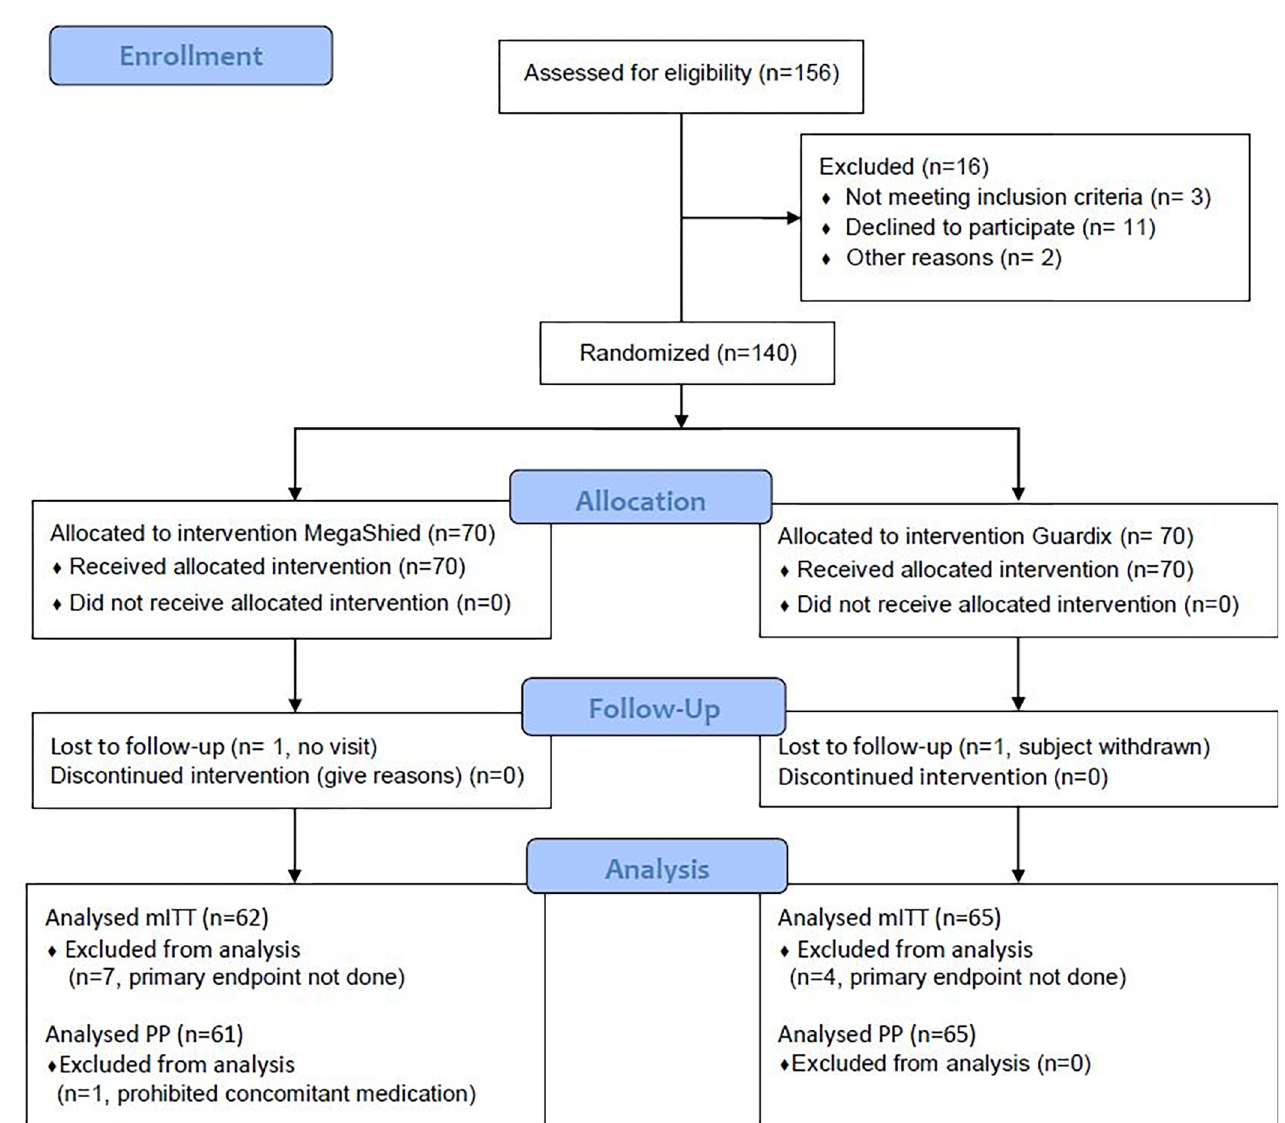
Fig 1. Disposition of patients. https://doi.org/10.1371/journal.pone.0273215.g001 Kangbuk Samsung hospital, and 26 from Seoul St. Mary’s Hospital (S1 Table). No deviation occurred in the randomization process. One patient in the MegaShield 1 group was excluded due to loss of follow-up. One patient in the Guardix-SG 1 group was excluded due to the patient’s request after surgery. During the first efficacy evaluation, the marshmallow esophago- graphy, 11 patients (7 patients in MegaShield 1 group and 4 in Guardix-SG 1 group) who swal- lowed saliva multiple times within 30 seconds or did not swallow saliva even after 30 seconds were considered as protocol deviation. Thus, mITT analysis was conducted on 127 patients (62 in MegaShield 1 group and 65 in Guardix-SG 1 group). After marshmallow esophagogra- phy, one patient in MegaShield 1 group was found to have consumed aspirin and was excluded from the study. Hence, PP set included 126 patients (61 in MegaShield 1 group and 65 in